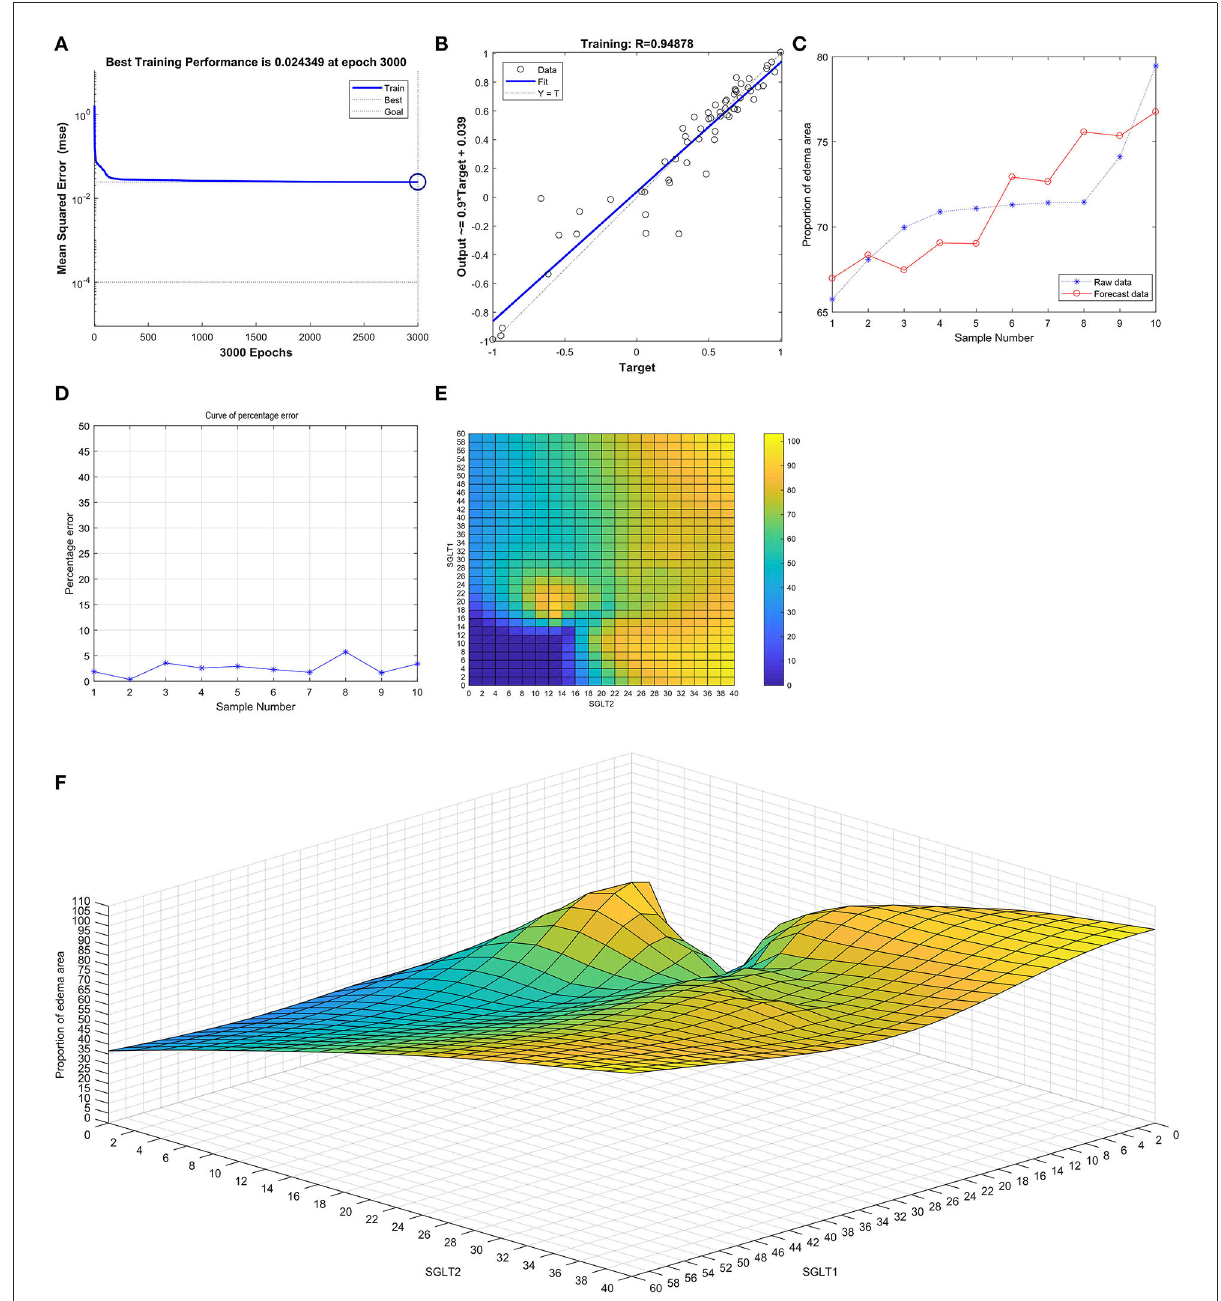
FIGURE9 Neural network prediction model and high-risk warning range of renal edema based on the expression of SGLT1 and SGLT2. (A) After training the BP neural network of SGLT1 and SGLT2 for renal edema, the best training performance was 0.024349 at epoch 3000. (B) Relativity was 0.94878. (C,D) By verifying the forecast data against the raw value, we found that there were only small differences. (E,F) High-risk warning indicator of renal edema: 16 < SGLT1 < 26 and 8 < SGLT2 <